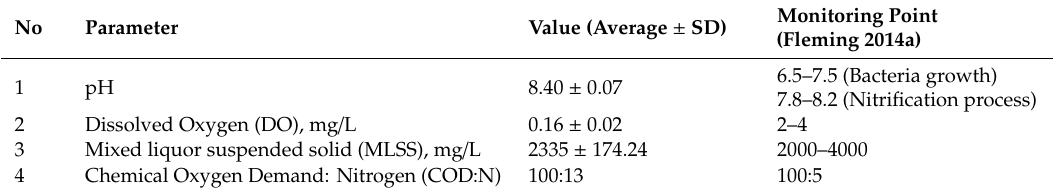
Table 7. Operational parameters based on laboratory